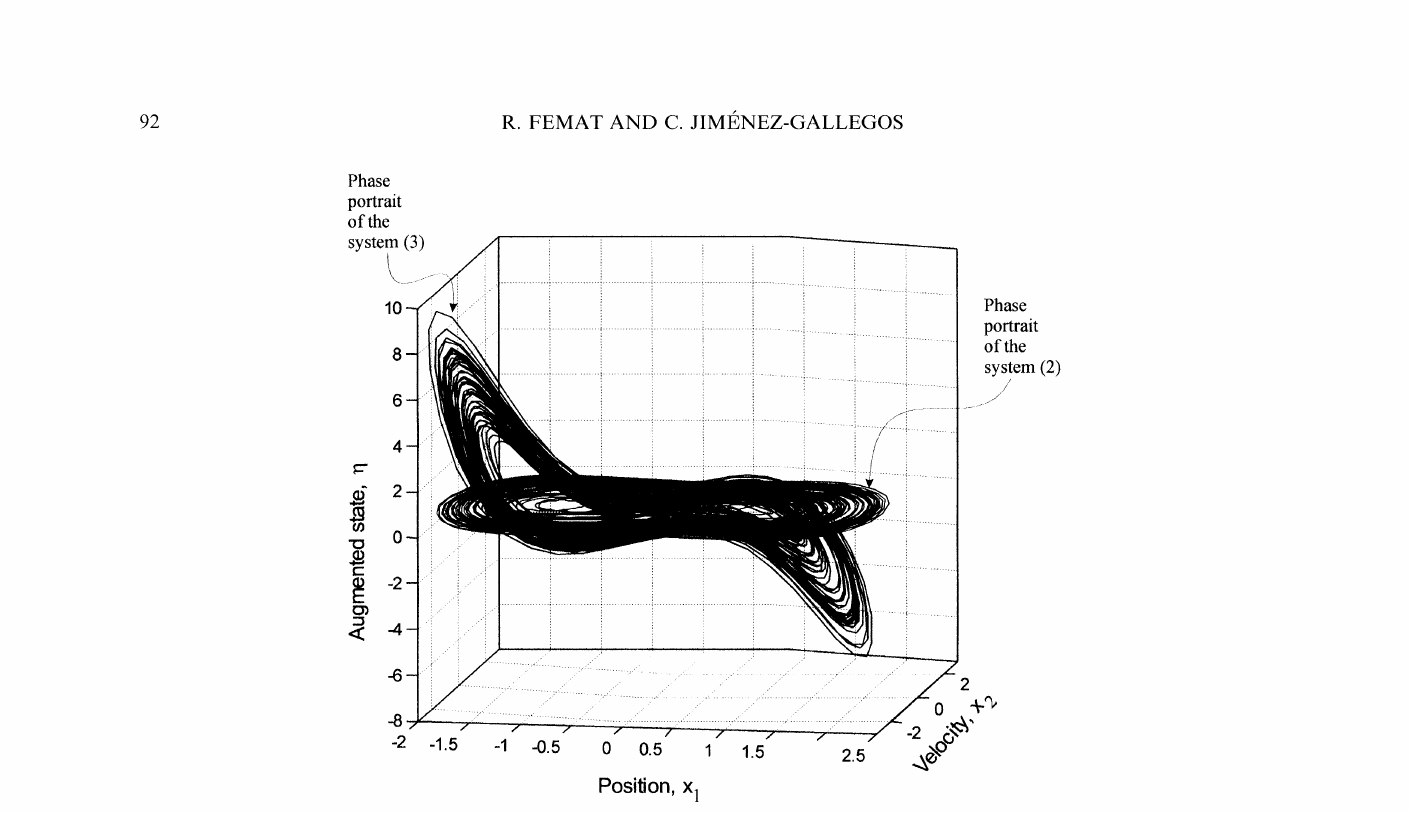
FIGURE Blue line is the space-phase of the Duffing sequation whereas black line represents the trajectories of the Duffing extended